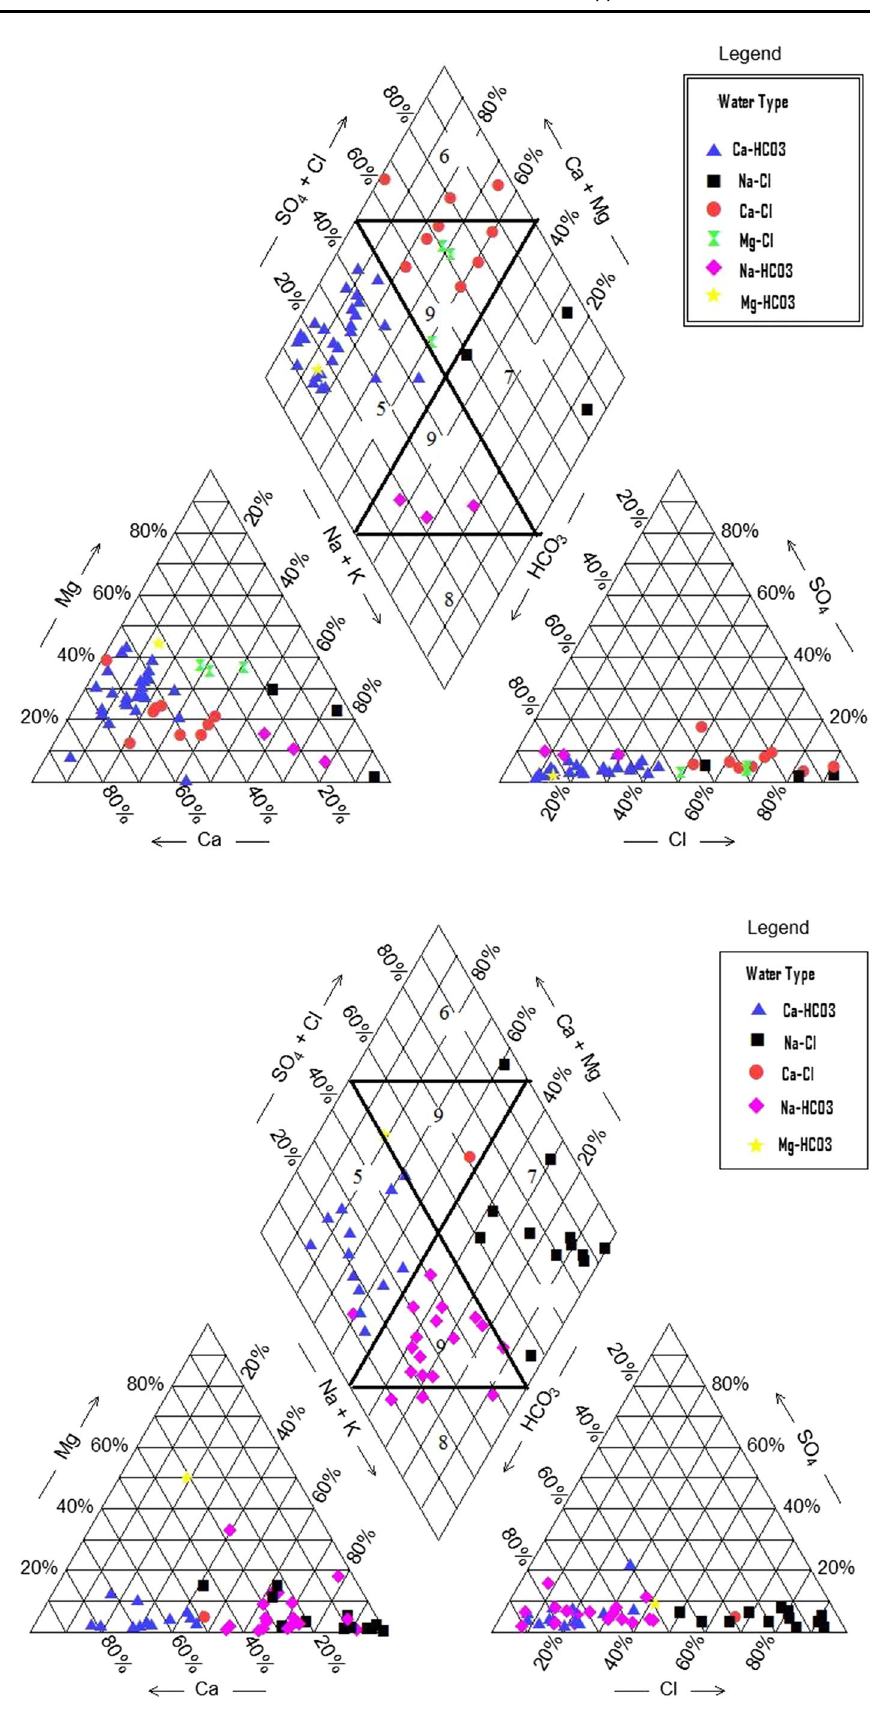
Fig. 10 Hydrochemical facies of groundwater in the dry season